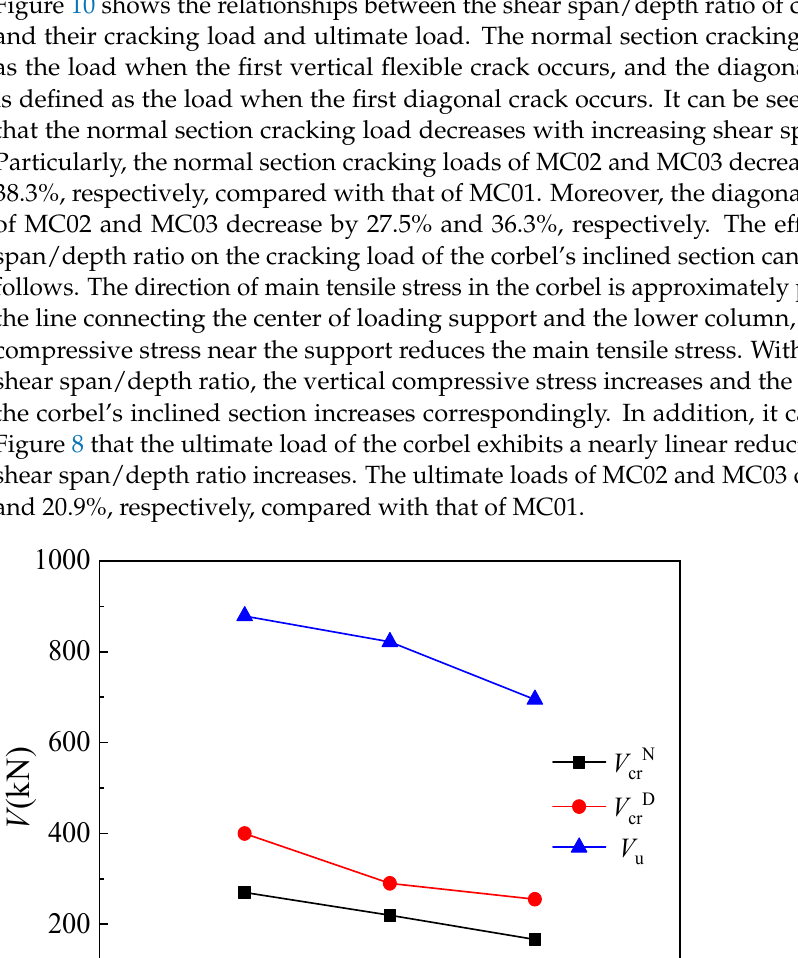
Figure 9. Relationship between load and average strain of longitudinal reinforcement under di ff er- ent ρ f .